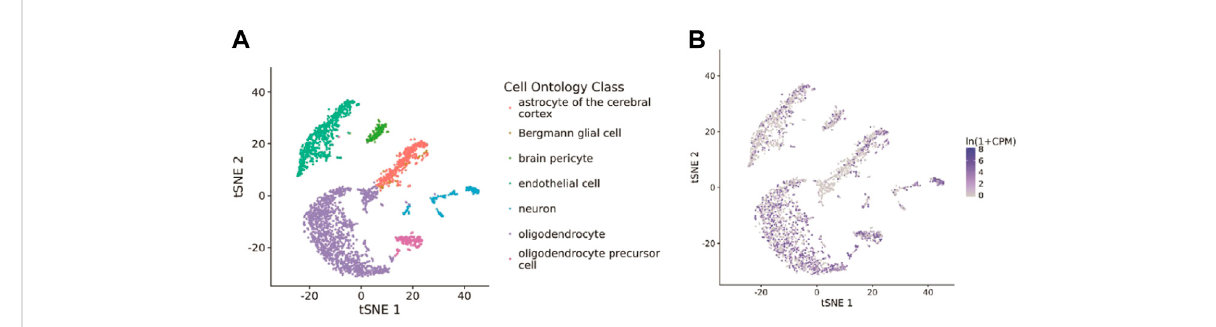
FIGURE 8 Single-cellanalysisofCOMMD4expression (A) Thecellsthatwerelinkedtothetissuesextractedfromthebrain. (B) TheCOMMD4expressionin tissues extracted from the brain.